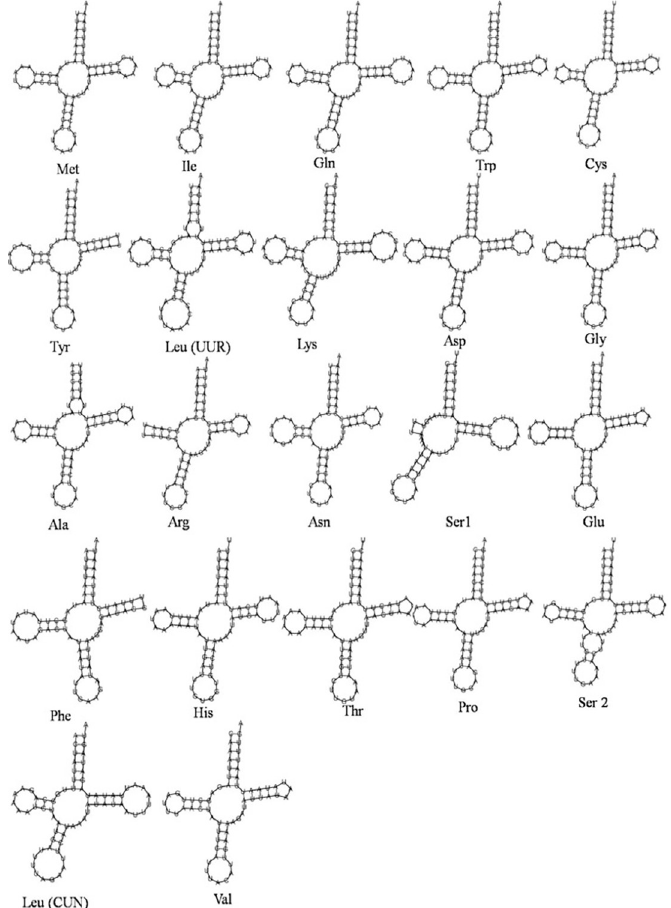
Fig 2. Predicated secondary clover-leaf structures for the 22 tRNA genes of Chrysodeixis acuta . The tRNAs are labled with abbreviation of their corresponding amino acids below each tRNA gene structure. Arms of tRNAs (clockwise from top) are the amino acid acceptor arm, TYC arm, the anticodon arm, and dihydrouridine (DHU) arm.